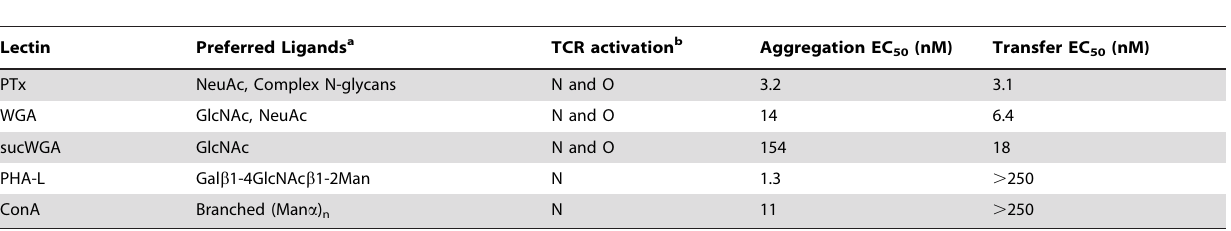
Lectin Preferred Ligands a TCR activation b Aggregation EC 50 (nM) Transfer EC 50 (nM) PTx NeuAc, Complex N-glycans N and O 3.2 3.1 N and O 14